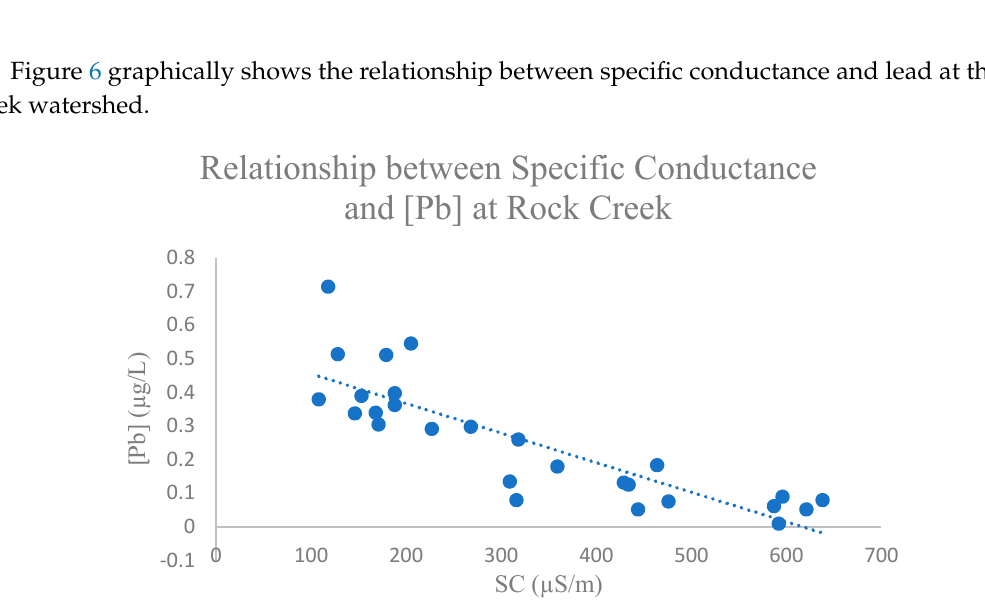
Figure 6. Relationship between specific conductance and lead concentrations at the Rock Creek watershed (R 2 = 0.71).